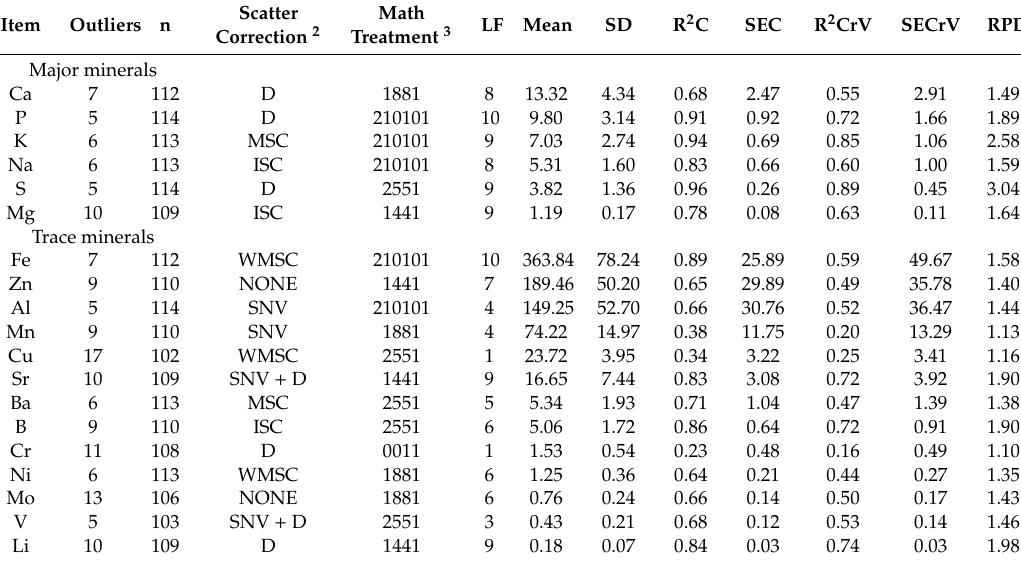
Table 4. Fitting statistics for modified partial least square regression models developed for major (g / kg in dry matter basis ) and trace mineral content (mg / kg in dry matter basis) in ground commercial extruded dry dog food samples 1 .